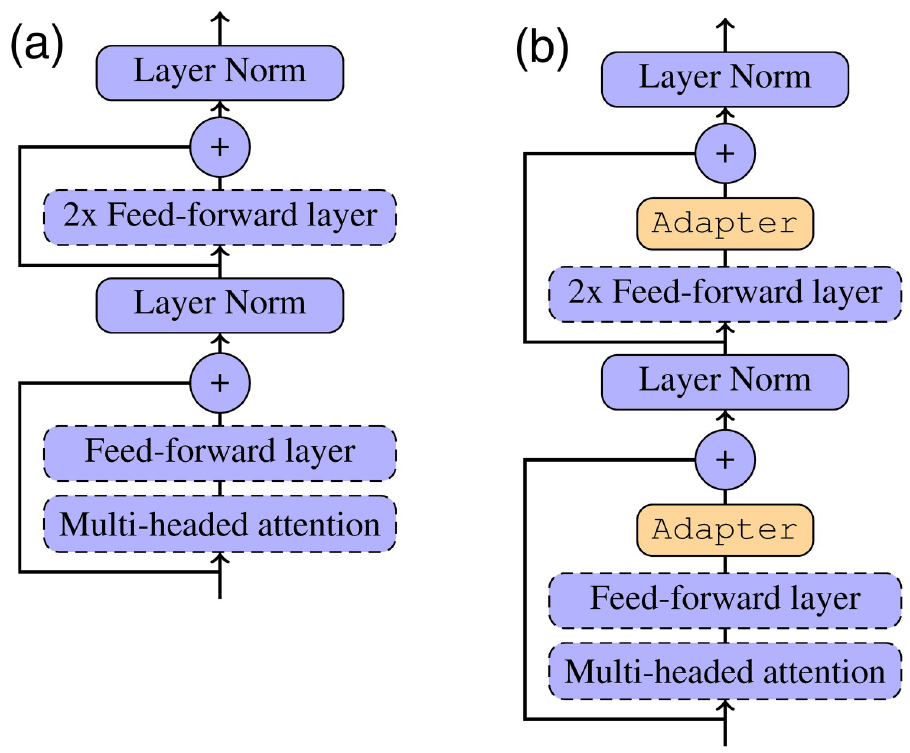
Fig 2. The internal structure of a one-layer transformer. (a) Standard Transformer. (b) Transformer with Adapters.